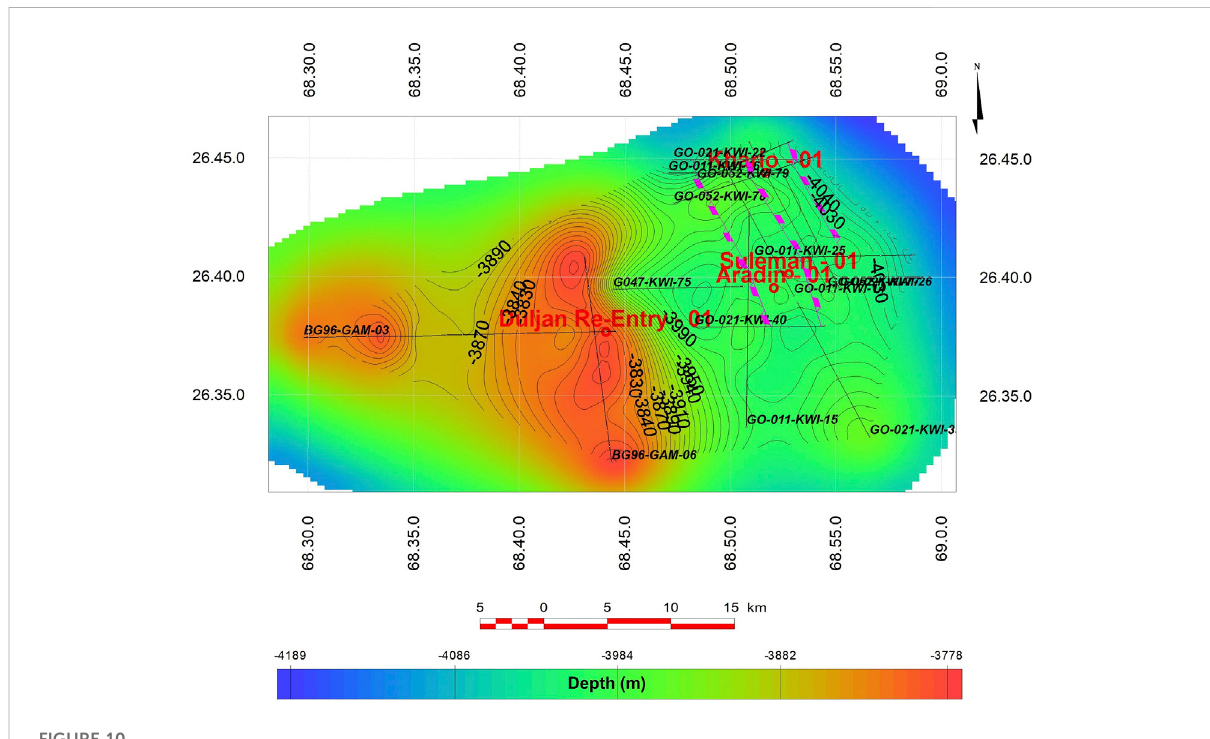
FIGURE 10 Depth structure map of sands of the Sembar